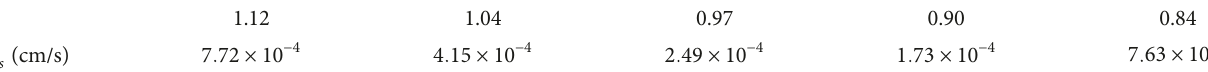
Table 1: Measured values of saturated hydraulic conductivity of Hunan clay.